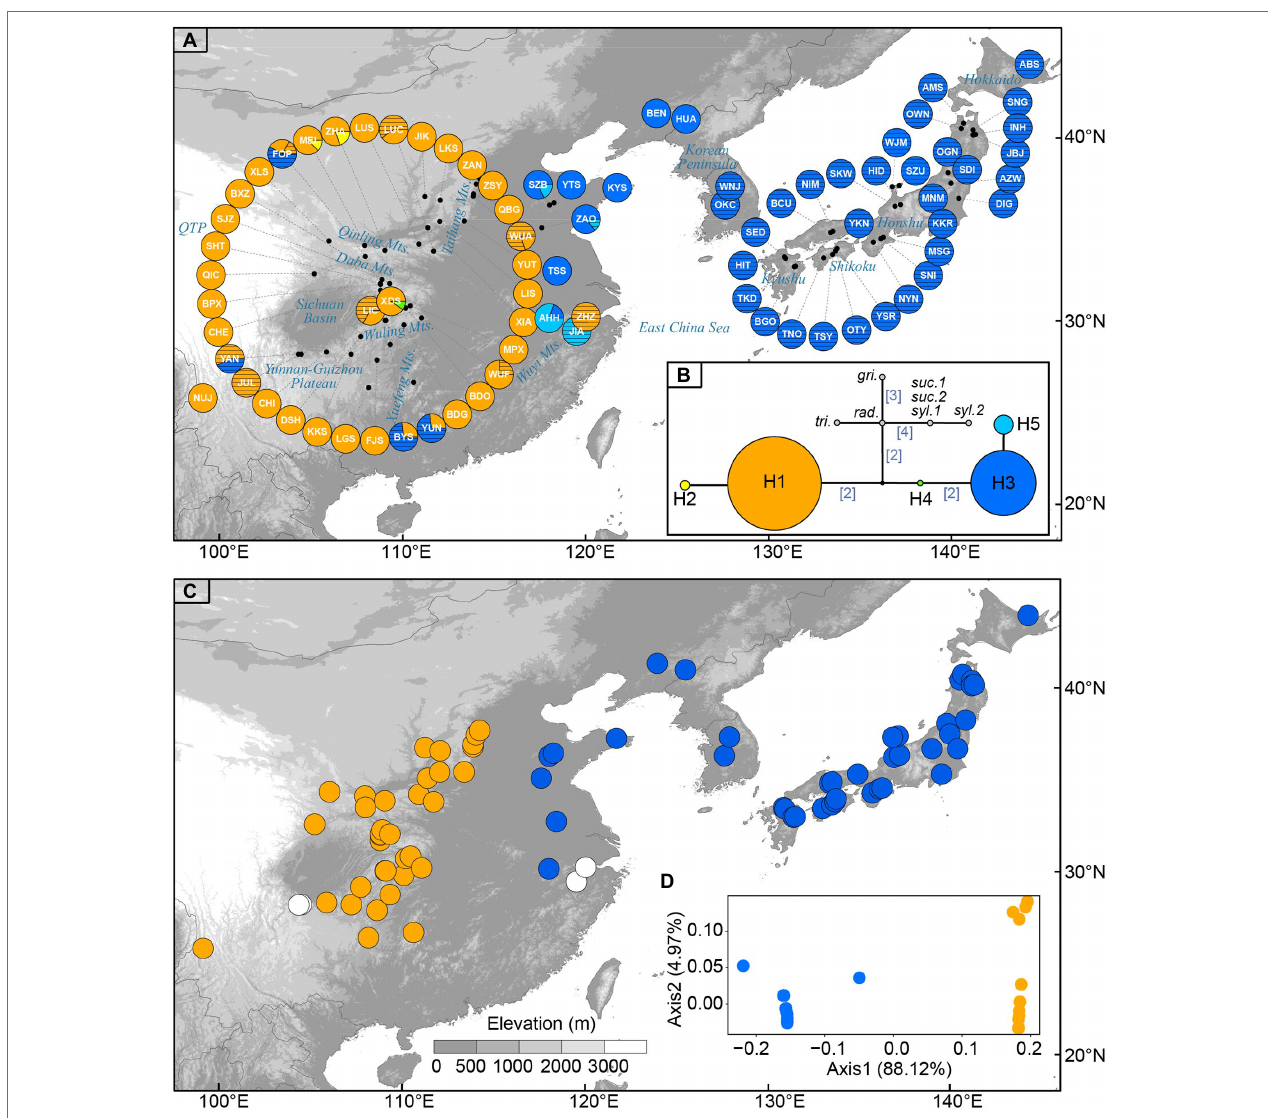
FIGURE 1 | (A) Sampling sites of Toxicodendron vernicifluum in East Asia and geographic distribution of the five chloroplast (cp) haplotypes identified in this study. Each pie chart represents a sampling site (see Table 1 for site codes) and each haplotype is represented with a different color as shown in (B) . Sectors marked by black lines represent cultivated trees. ( B ) Median-joining network of cpDNA haplotypes estimated by POPART. Numbers in brackets on branches indicate the number of mutations between haplotypes when branches represent more than one mutation. Outgroups include Toxicodendron griffithii ( gri .), Toxicodendron radicans ( rad. ), Toxicodendron trichocarpum ( tri. ), Toxicodendron succedaneum ( suc. ), and Toxicodendron sylvestre ( syl. ). (C) The western (orange) and eastern (blue) groups were identified by spatial analysis of molecular variance (SAMOVA) when K = 2. White circles represent sampling sites only including cultivated trees in mainland China. (D) Results of principal coordinate analysis (PCoA) based on the matrix of population pairwise F ST . Orange and blue circles represent the western and eastern groups,